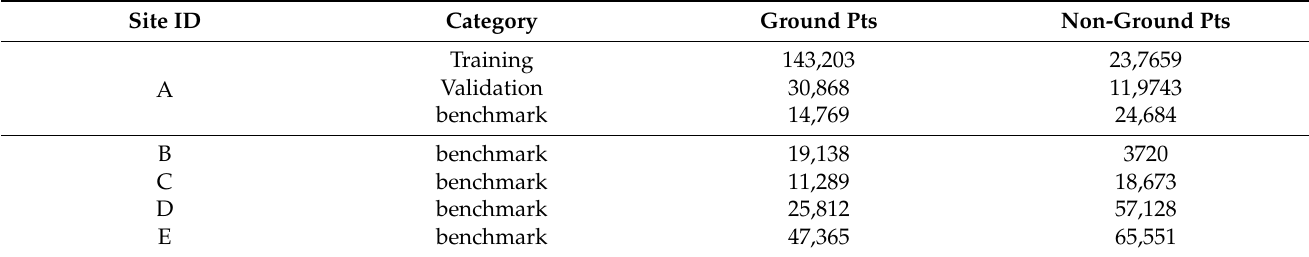
Table 3. Summary statistics of training, validation, and benchmark point clouds for study